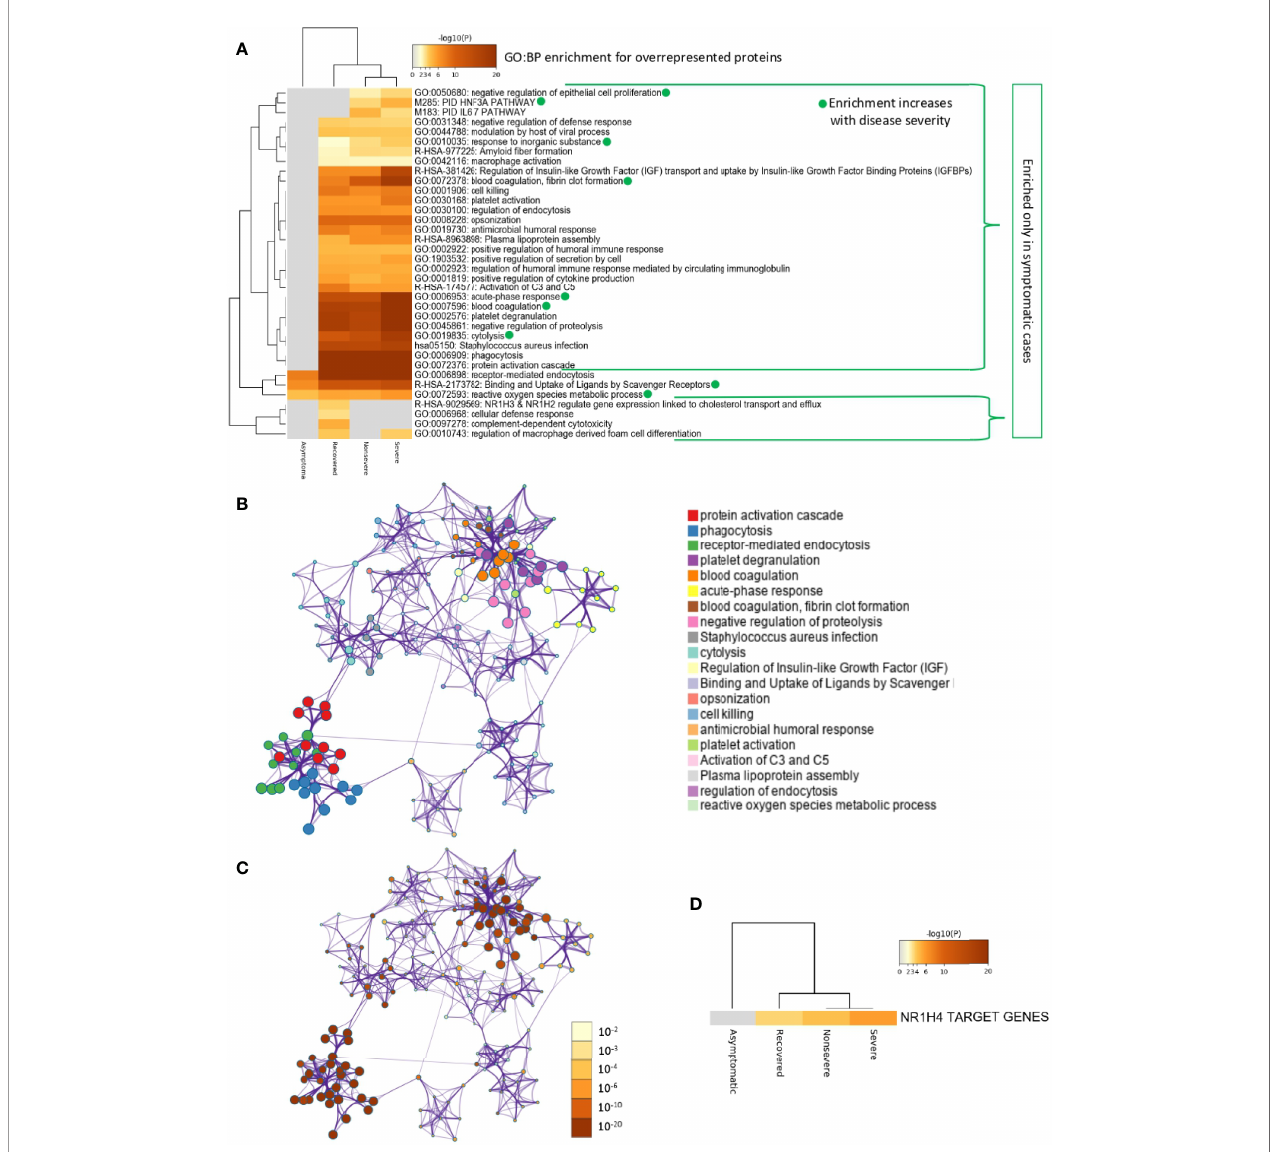
FIGURE 5 | Enrichment ontology clusters for differentially overrepresented proteins in sera from COVID-19 cases. (A) Statistically enriched terms (GO/KEGG biological processes; GO : BP). Accumulative hypergeometric p -values and enrichment factors were calculated and used for fi ltering. Remaining signi fi cant terms were then hierarchically clustered into a tree based on Kappa-statistical similarities among their protein memberships (as used in DAVID Bioinformatics Resources 6.8; https://david.ncifcrf.gov). A 0.3 Kappa score was applied as the threshold to cast the tree into term clusters. The term with the best p -value within each cluster was selected as its representative term and displayed in a dendrogram. The heatmap cells are colored by their p -values; white cells indicate the lack of enrichment for that term in the corresponding gene list. BPs in which enrichment increased with disease severity only in symptomatic cases are shown. (B) Network of enriched terms. We selected a subset of representative terms from the full cluster and convert them into a network layout. More speci fi cally, each term is represented by a circle node, where its size is proportional to the number of input genes that fall into that term, and its color represents its cluster identity (i.e., nodes of the same color belong to the same cluster). Terms with a similarity score > 0.3 are linked by an edge (the thickness of the edge represents the similarity score). The network is visualized with Cytoscape (v3.1.2) with “ force-directed ” layout and with edge bundled for clarity. One term from each cluster is selected to have its term description shown as label. (C) Network of enriched terms colored by p -value. The same enrichment network has its nodes colored by p -value, as shown in the legend. The darker the color, the more statistically signi fi cant the node is (see legend for p -value ranges). (D) Quality control and association analysis. Protein lists were identi fi ed in the ontology categories Transcription_Factor_Targets. All genes in the genome were used as the enrichment background. Terms with a p -value < 0.01, a minimum count of 3, and an enrichment factor (ratio between the observed counts and the counts expected by chance) > 1.5 were collected and grouped into clusters. The algorithm used here is the same as that used in the other enrichment